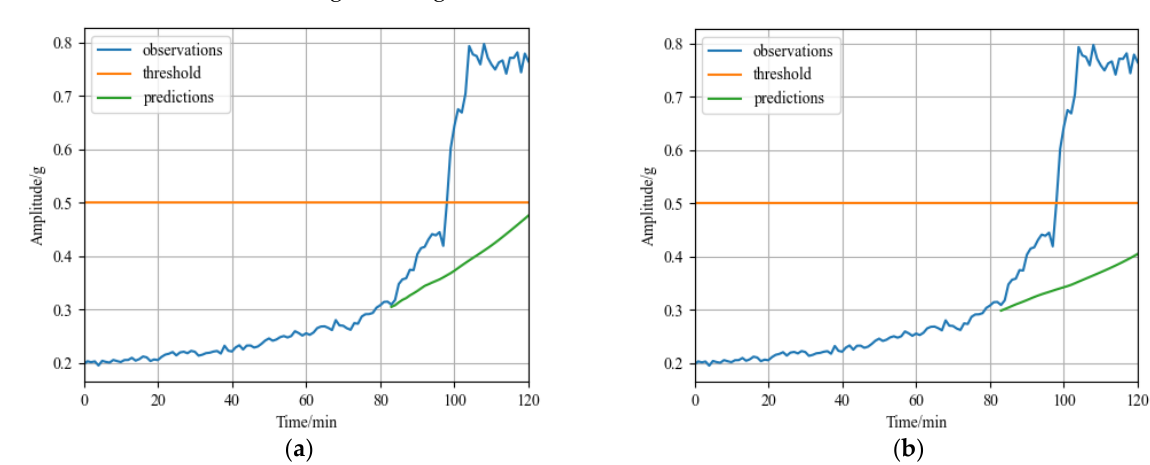
Figure 13. Comparative experiment results of self-made rolling bearing accelerated degradation testbed dataset: ( a ) RUL prediction result of CNN model; and ( b ) RUL prediction result of LSTM model.